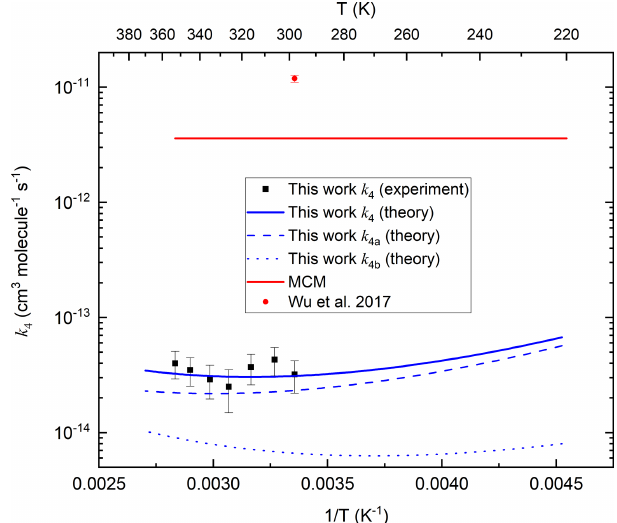
Figure 9. Rate coefficients ( k 4 , k 4a and k 4b ) for the OH + CH 3 C(O)OOH reaction. MCM is the value used in the Master Chemical Mechanism. The error bars in the present dataset include uncertainty in the value of k (cid:48) and IR absorption cross- 4 sections of CH 3 C(O)OOH. As described in the text, there are several reasons why the experimental rate coefficients should be regarded as upper